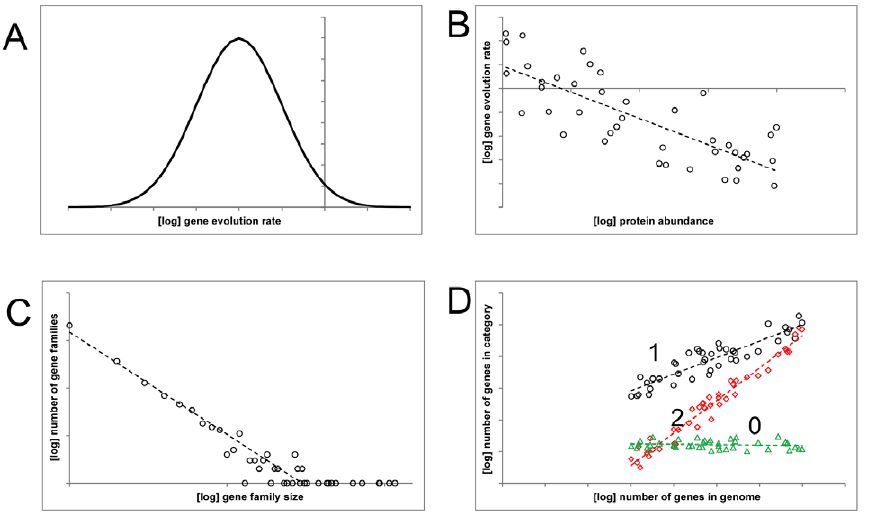
Figure 1. Universals of genome and molecular phenome evolution. The figure shows idealized versions of universal dependencies and distributions. The scattered points show the range of characteristic variance. (A) Log-normal distribution of evolutionary rates of orthologous genes. (B) Anticorrelation between gene expression level (protein abundance) and sequence evolution rate. (C) Power law–like distribution of paralogous family size. (D) Differential scaling of functional classes of genes with the total number of genes in a genome. Three fundamental exponents are thought to exist: 0 – no dependence, typical of translation system component; 1 – linear dependence, characteristic of metabolic enzymes; 2 – quadratic dependence, characteristic of regulatory and signal transduction system components.